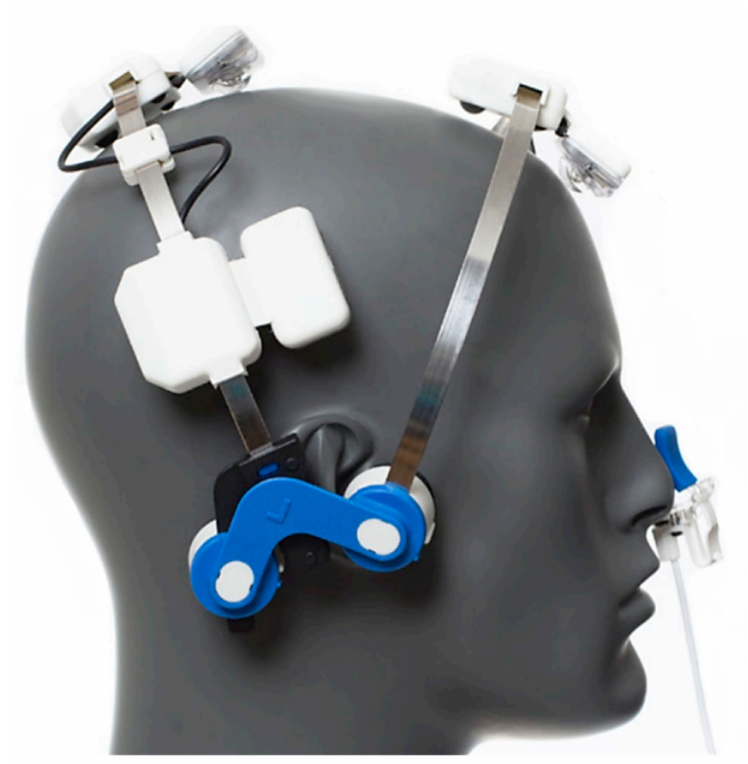
Figure 1. Positioning of the tPBM on the head, which is composed of a helmet and a nasal stimulator. LED diodes emit non-thermal, non-laser light at an intensity that penetrates the scalp, skull, and meninges to a depth of ~40 mm, stimulating cortical brain areas (Jagdeo et al., 2012; Tedford et al., 2015) [39,40] and is powered by three rechargeable NiMH batteries. The posterior transcranial LEDs have a power of 100 milliwatts (mW) and the anterior tran- scranial has a power of 75 mW. Each posterior transcranial LED has a power density of 100 mW/cm 2 and the anterior transcranial LED of 75 mW/cm 2 . The beam spot size